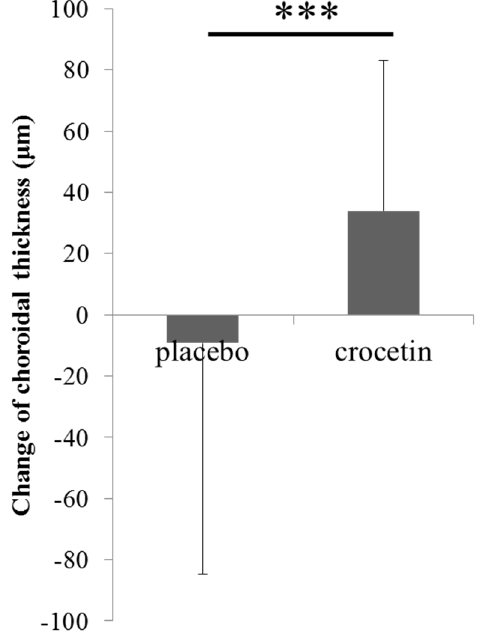
Figure 3. Change in the choroidal thickness for 24 weeks.